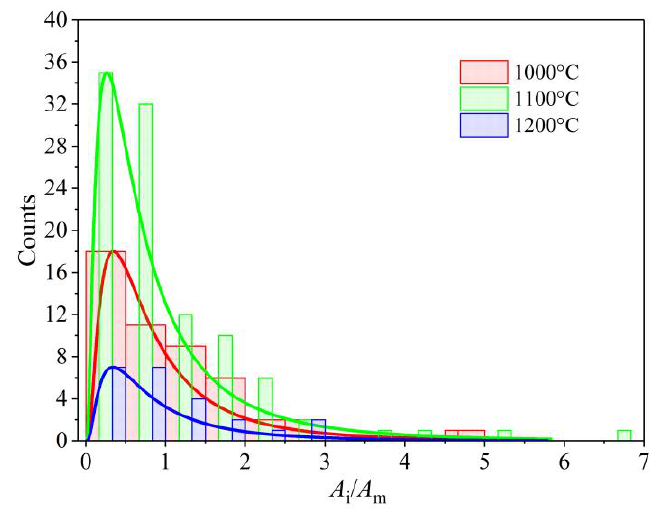
Figure 16. Column plots and lognormal distribution curves showing the A i / A m ratios for the microstructures etched at 1000 °C (red curve), 1100 °C (green curve) and 1200 °C (blue curve). Original data are taken from [31].